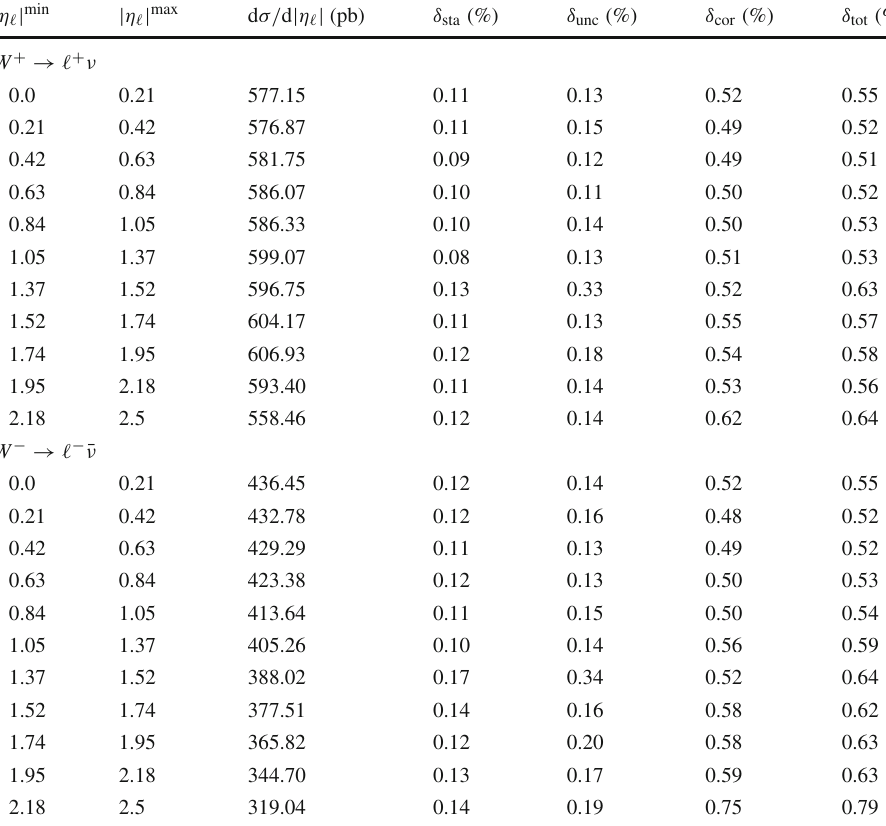
Table 12 Differential cross section for the W + → (cid:3) + ν (top) and W − → (cid:3) − ¯ ν (bottom) processes, extrapolated to the common fiducial region. The relative statistical ( δ sta ), uncorrelated systematic ( δ unc ), correlated systematic ( δ cor ), and total ( δ tot ) uncertainties are given in percent of the cross-section values. The overall 1 . 8% luminosity uncertainty is not